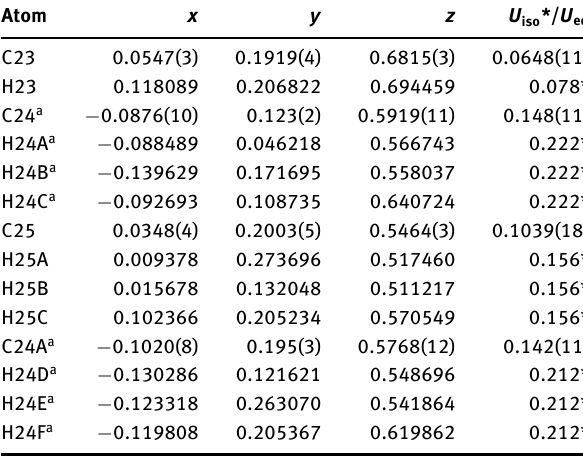
Table 2: Fractional atomic coordinates and isotropic or equivalent isotropic displacement parameters (Å 2